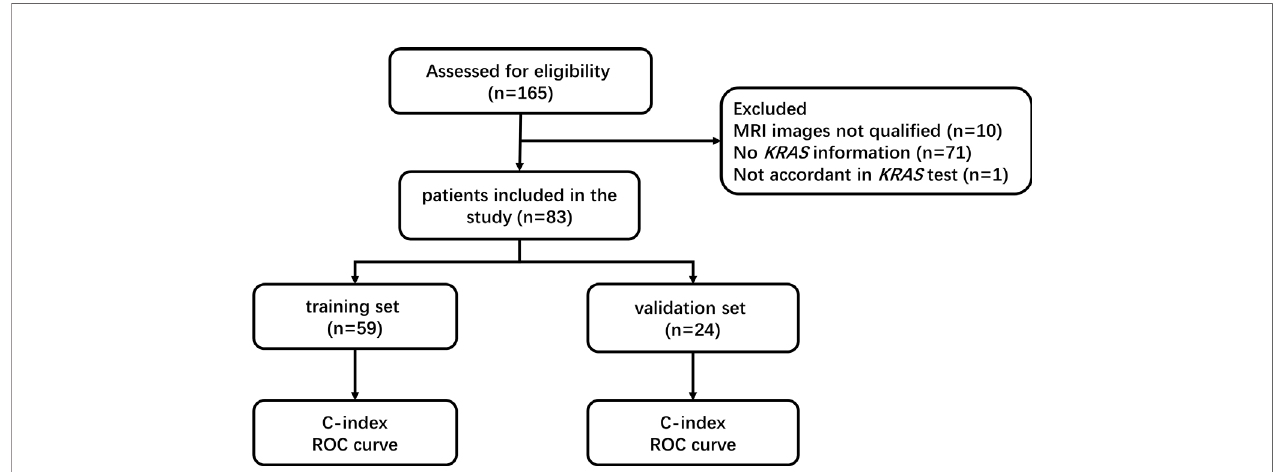
FIGURE 1 | Flow chart of the